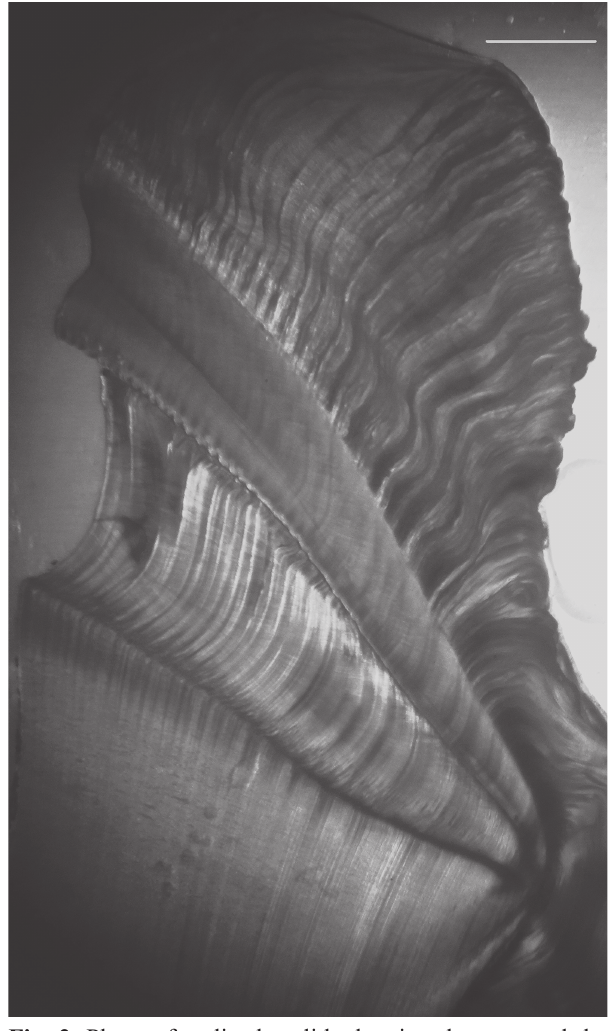
Fig. 2. Photo of a sliced otolith showing the core and the rings formed by the opaque and translucent bands. Scale of 1mm is